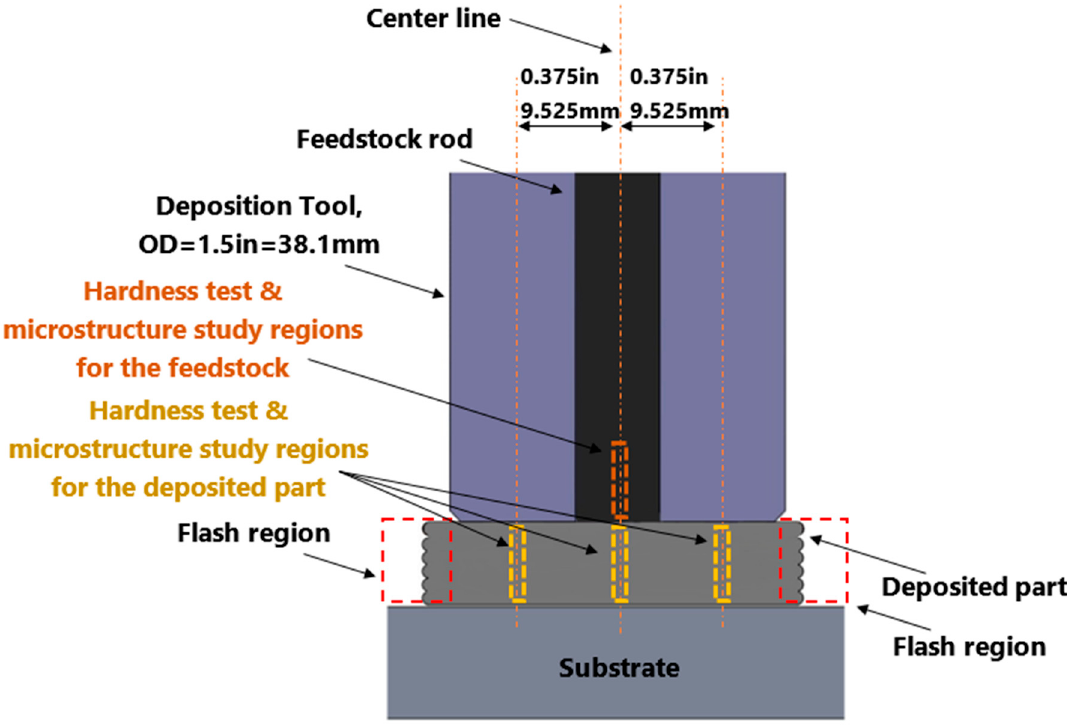
Figure 2. Schematic of the cross-section of the deposited Al2050 part and the feedstock rod, showing the regions chosen for the hardness test and studying the microstructure.